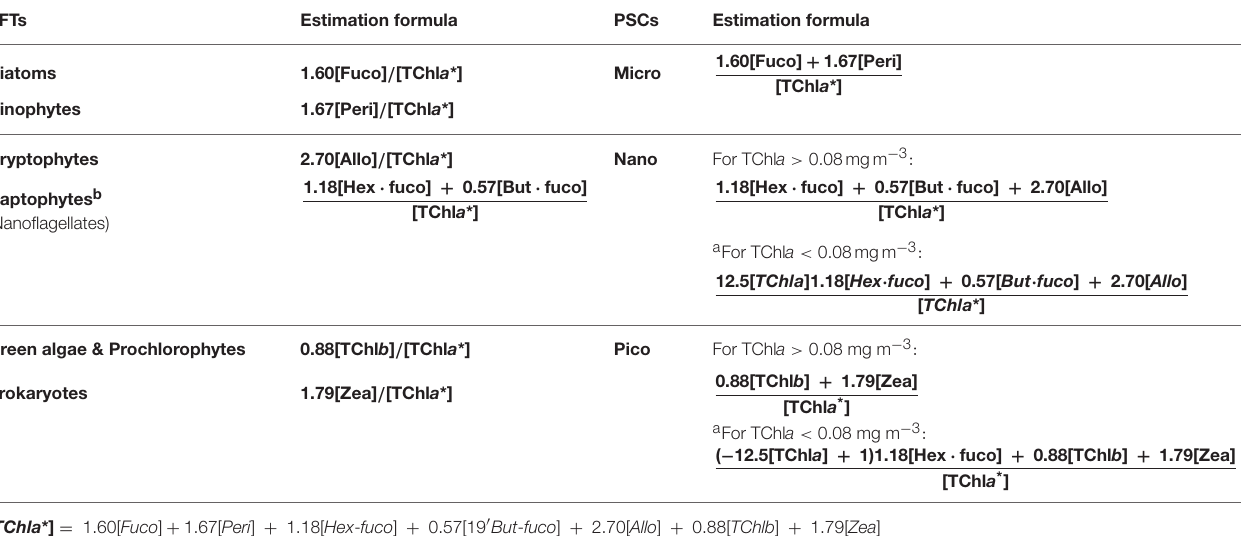
TABLE 3 | PSCs and PFTs used in this work with their in-situ estimation formulas (fraction of TChl a *, ranging from 0 to 1) resulted from the Diagnostic Pigment